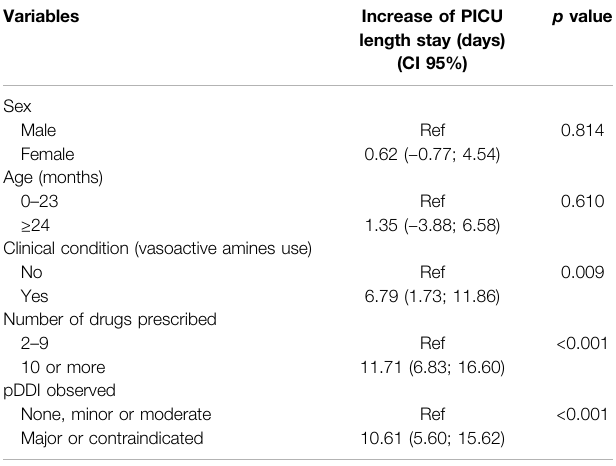
TABLE 3 | Association between the PICU length of stay and sex, age group, clinical condition, number of drugs prescribed, and pDDI observed ( n (cid:1) 143, Teaching Hospital PICU, Rio de Janeiro,